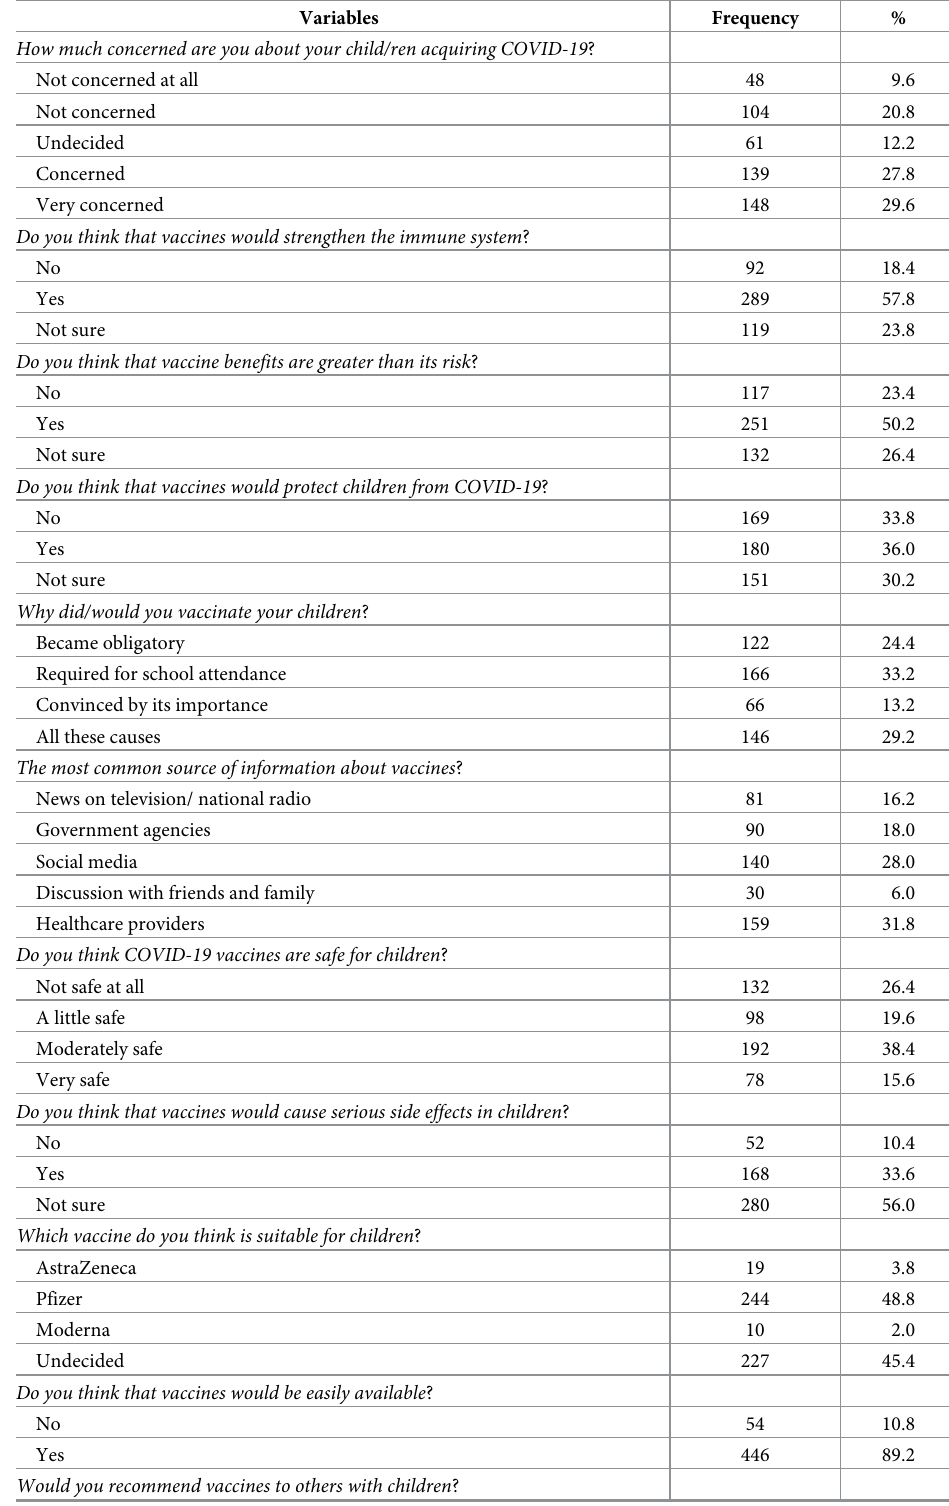
Table 2. Attitude of participants towards vaccines ( n =